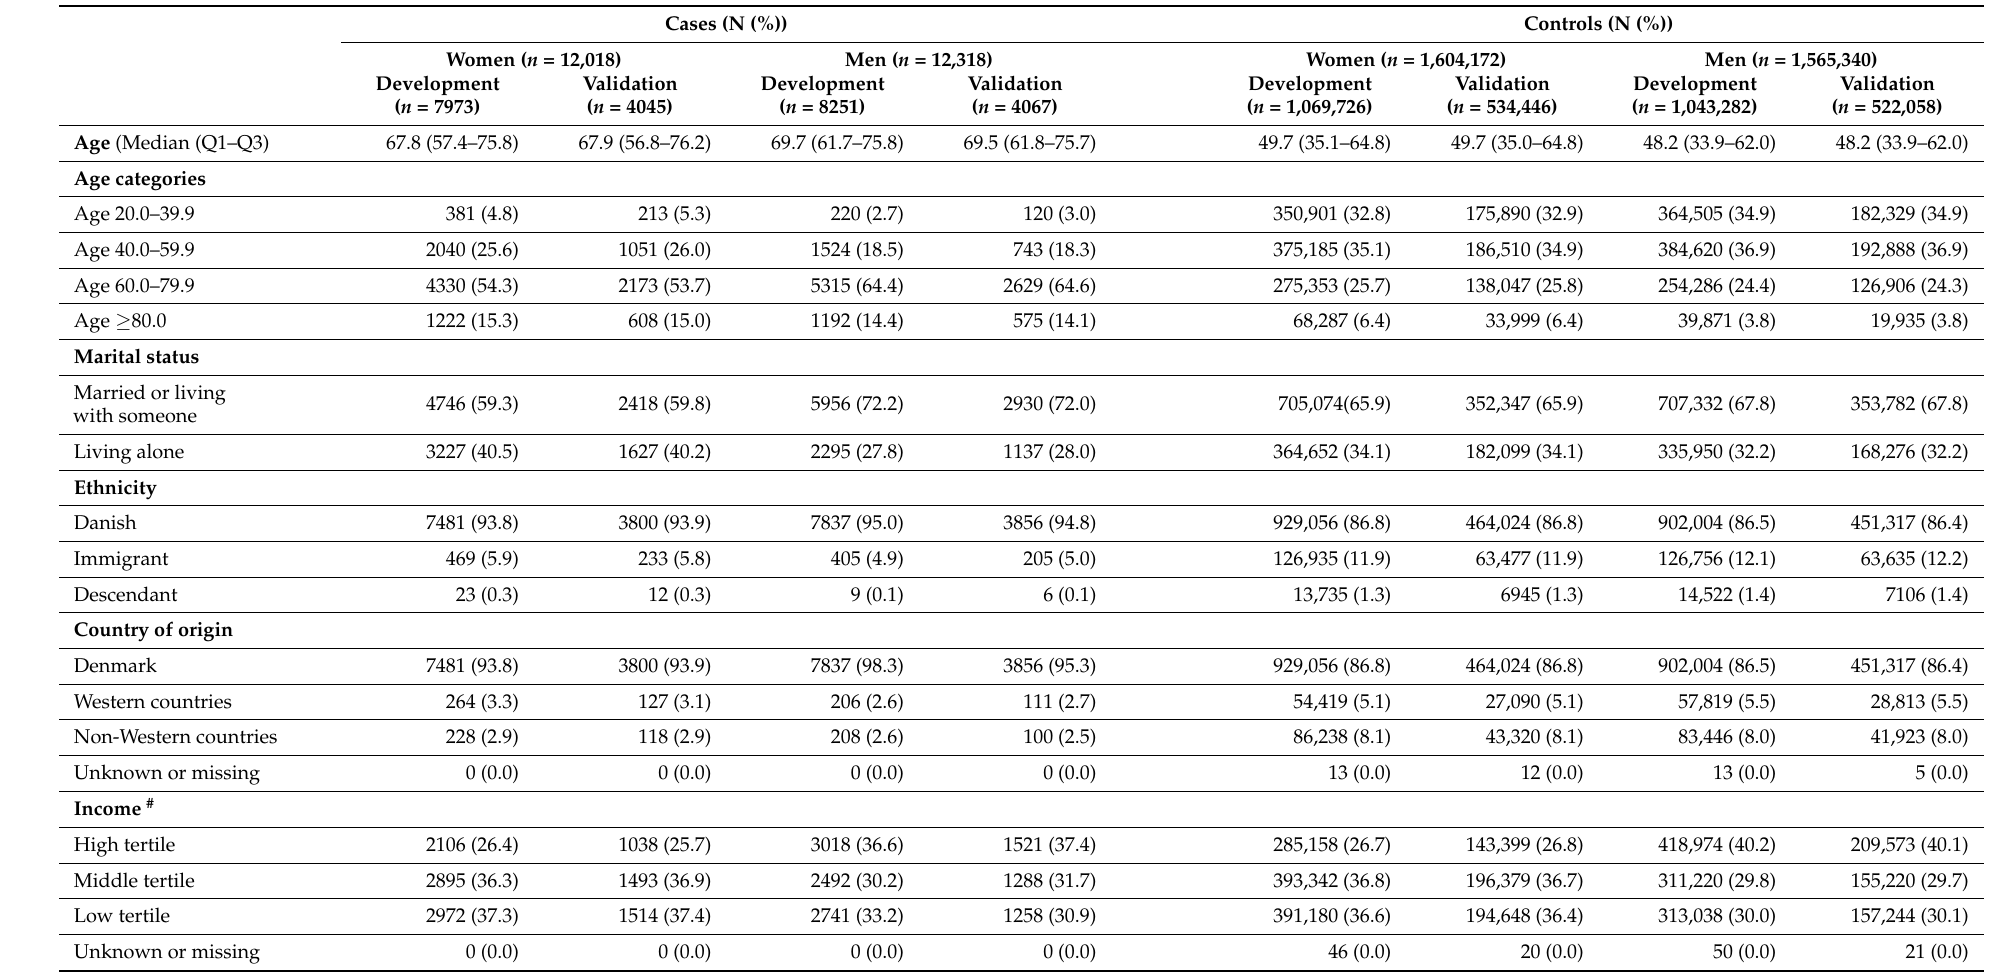
Table 1. Characteristics of the study population stratified by sex, and development and validation